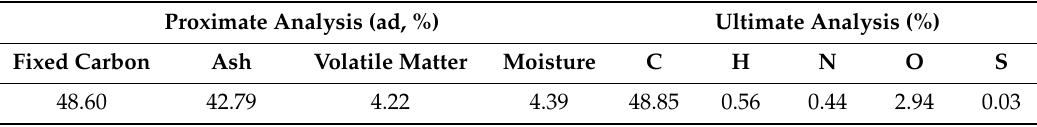
Table 1. Proximate and ultimate analyses of rice husk